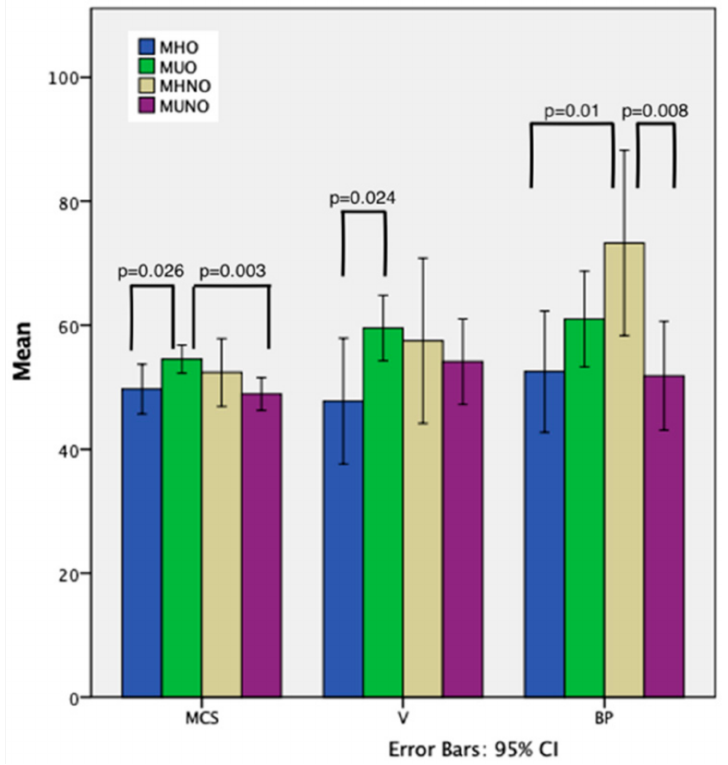
Figure 1. Mental Component Score (MCS), Vitality (V) and Bodily Pain (BP) means values across obesity